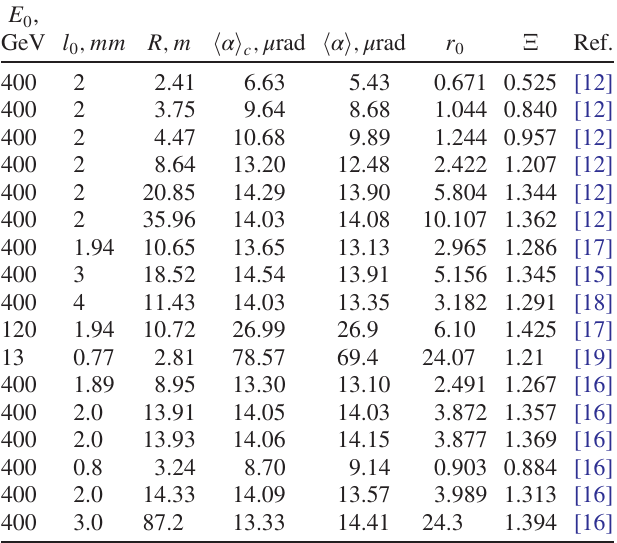
TABLE I. Experimental data for mean volume reflection angle for (110) plane in bent silicon crystals. Here h α i c and h α i are the calculated and measured values of the volume reflection angle.